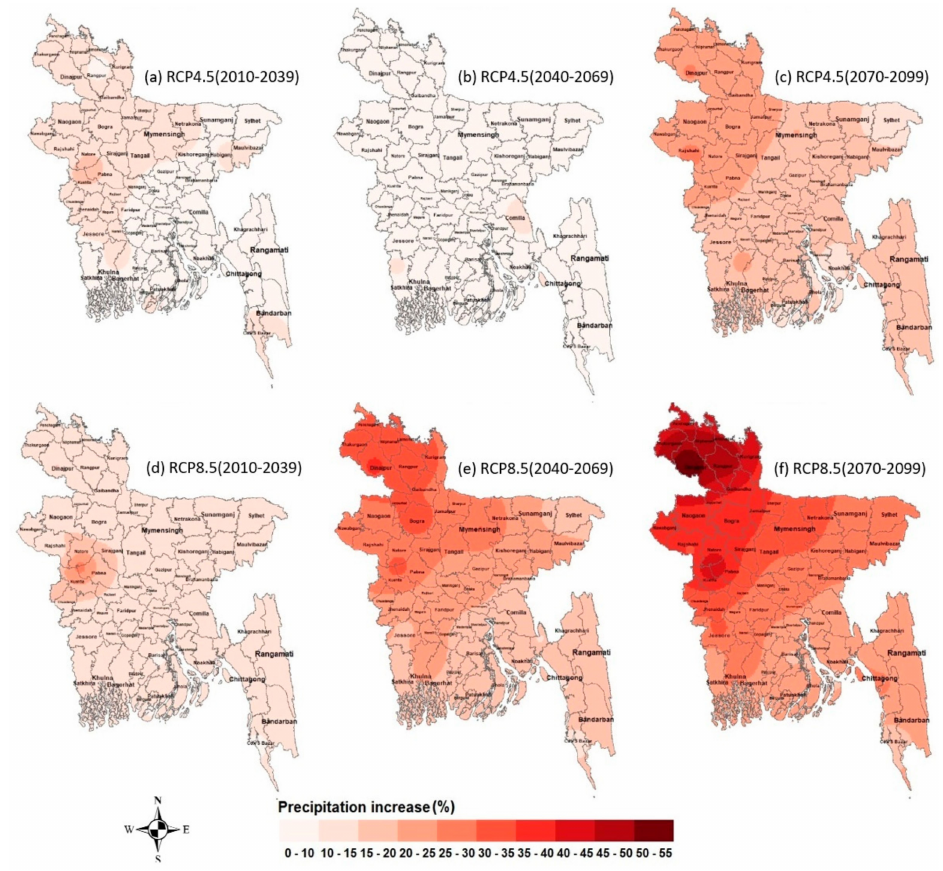
Figure 5. Percentage (%) change of precipitation over Bangladesh for the 2010s (1st column), 2040s (2nd column), and 2070s (3rd column) under the RCP4.5 (upper row) and (2) RCP8.5 (lower row) scenarios relative to the baseline period